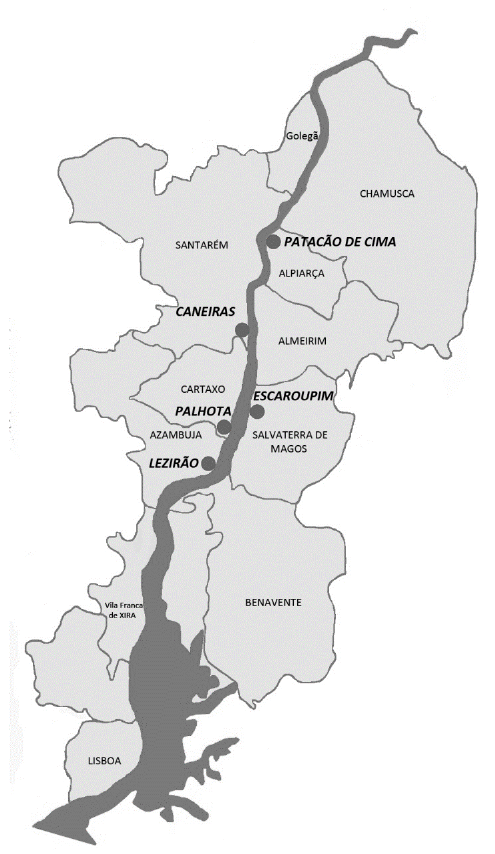
Figure 1: Avieiras villages located along the Tagus river: Caneiras, Escaroupim, Palhota, Lezirăo e Patacăo de Cima.